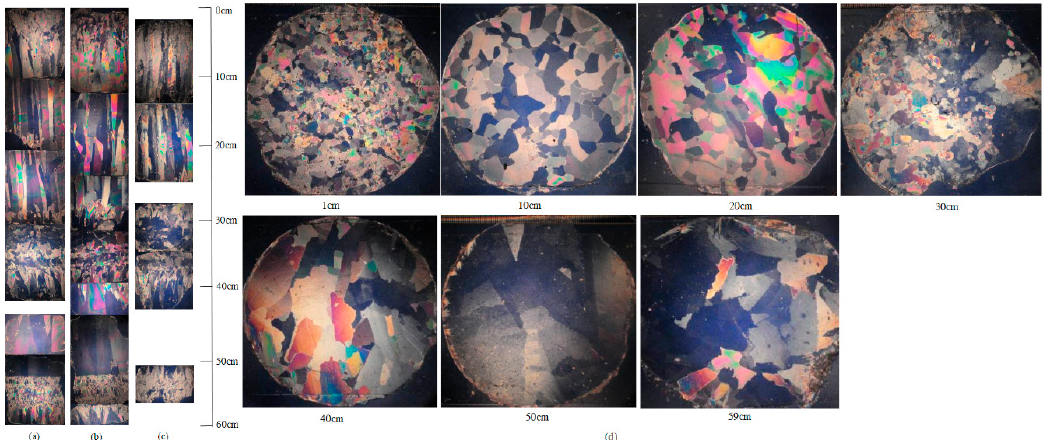
Figure 3. Ice microstructure at Point A in the Yellow River: ( a ) ice microstructure in the direction perpendicular to the ice surface (15th February); ( b ) ice microstructure in the direction perpendicular to the ice surface (24th February); ( c ) ice microstructure in the direction perpendicular to the ice surface (27th February); ( d ) ice microstructure of different ice layers parallel to the ice surface (24th February).